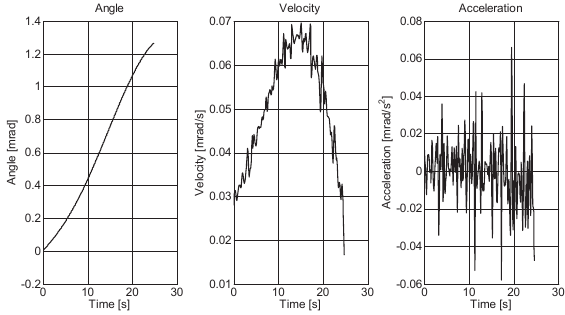
Figure 5: The results of the RC tests for sample S3057. Fig. 5. The results of the RC tests for sample S3057. Fig. 5. The results of the RC tests for sample S3057.